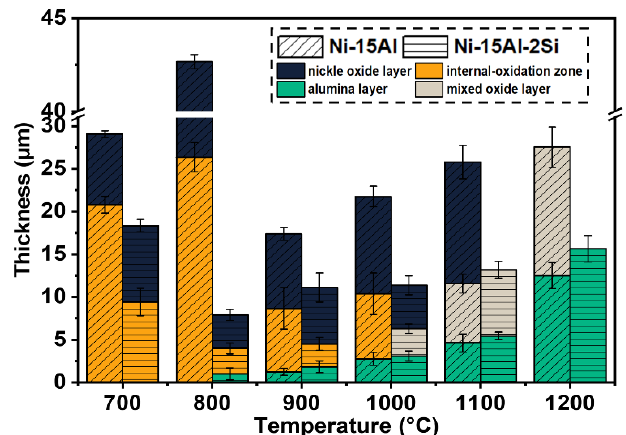
Figure 8. Effect of temperature on the type and thickness of oxide layers formed on Ni-15Al and Ni-15Al-2Si. Note that the formation of inner alumina layer is crucial to excellent oxidation resistance